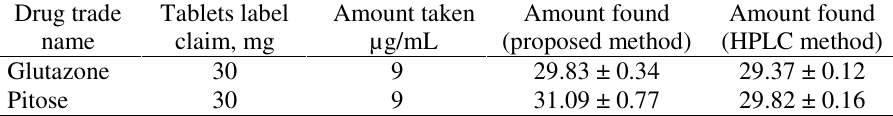
Table 3. Determination of pioglitazone in tablets using proposed and HPLC methods. Drug